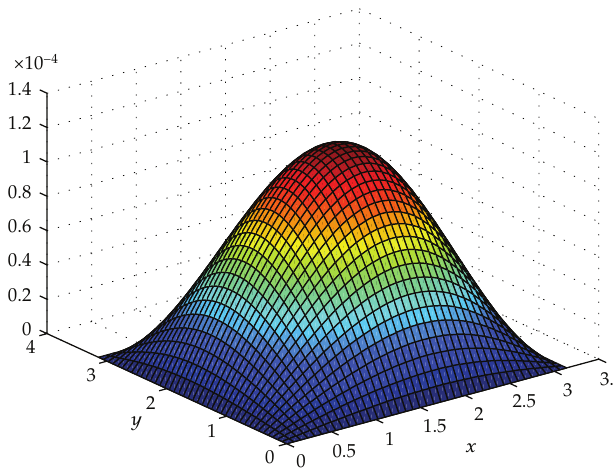
Figure 5: Absolute error when T (cid:9) 2, h (cid:9) π/ 40, and Δ t (cid:9) 0 . 1.